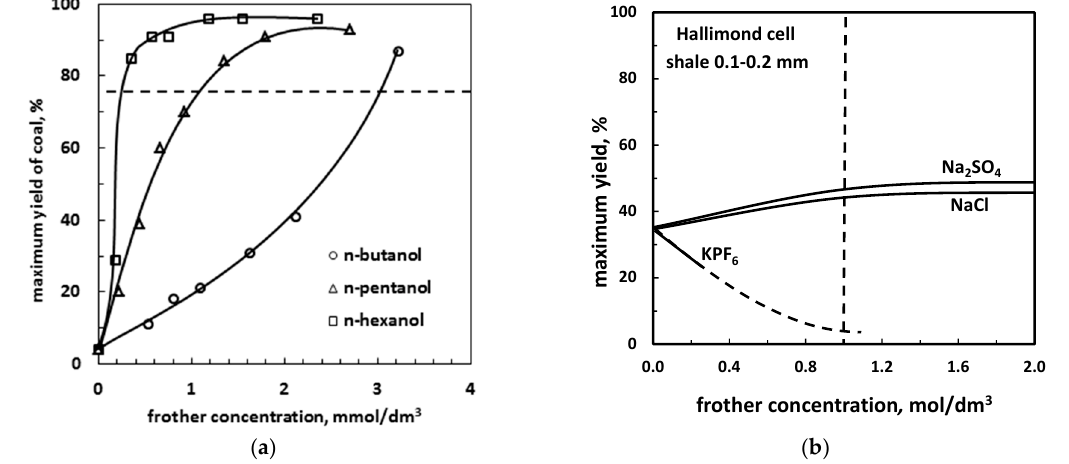
Figure 13. Cross sections of the yield versus frother concentration plot for creation of parameters useful for specific classification of frothers. ( a ) horizontal cross-section of Figure 13a providing frother strength; ( b ) vertical cross-section of Figure 13b providing molar effectiveness of the frother. Table 13. Strength and molar effectiveness for selected frothers, given solid and flotation device.